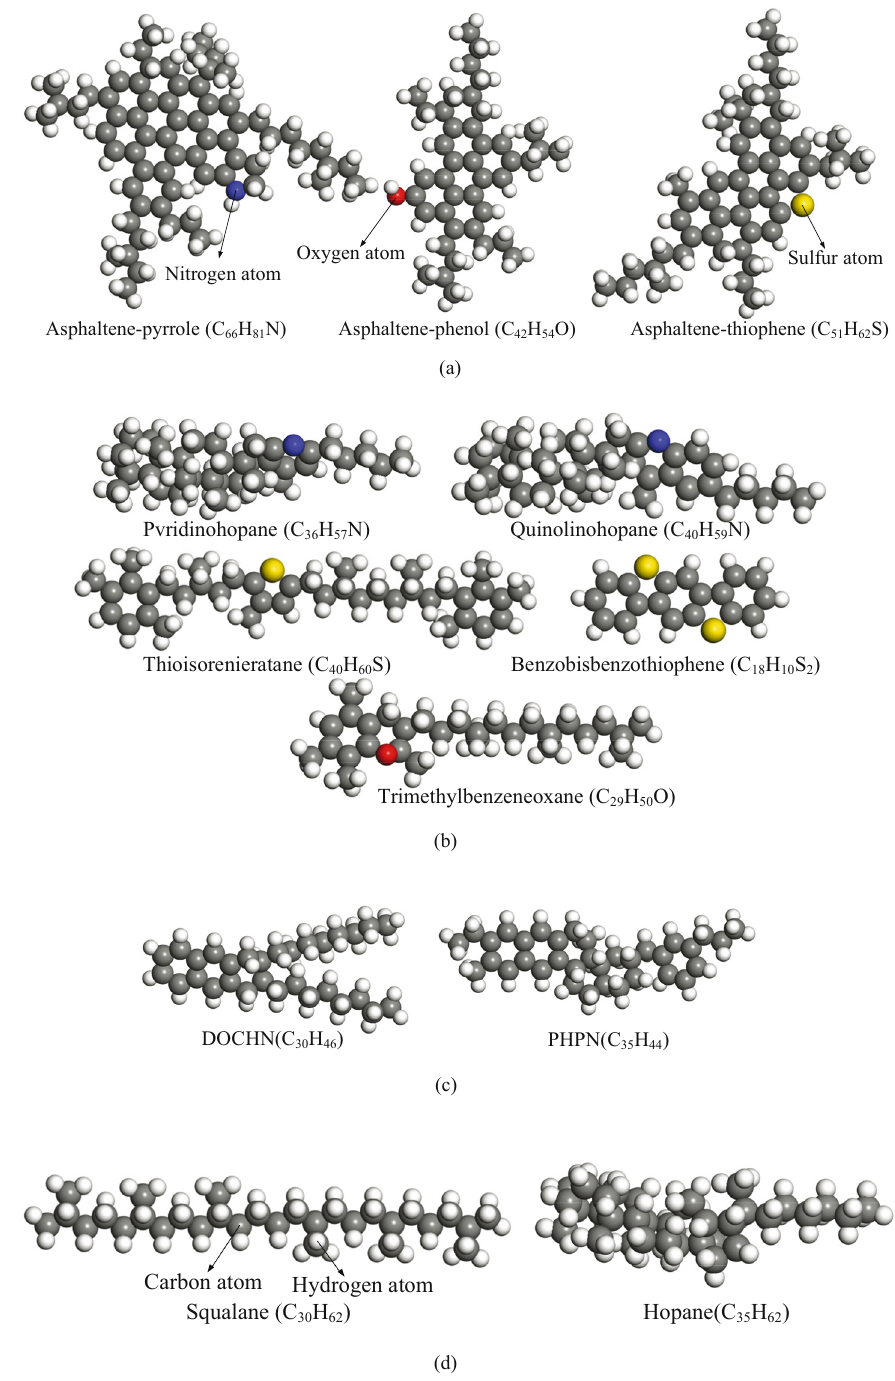
Figure 1: Twelve components of asphalt: ( a ) asphaltene, ( b ) resin, ( c ) aromatics, and ( d )